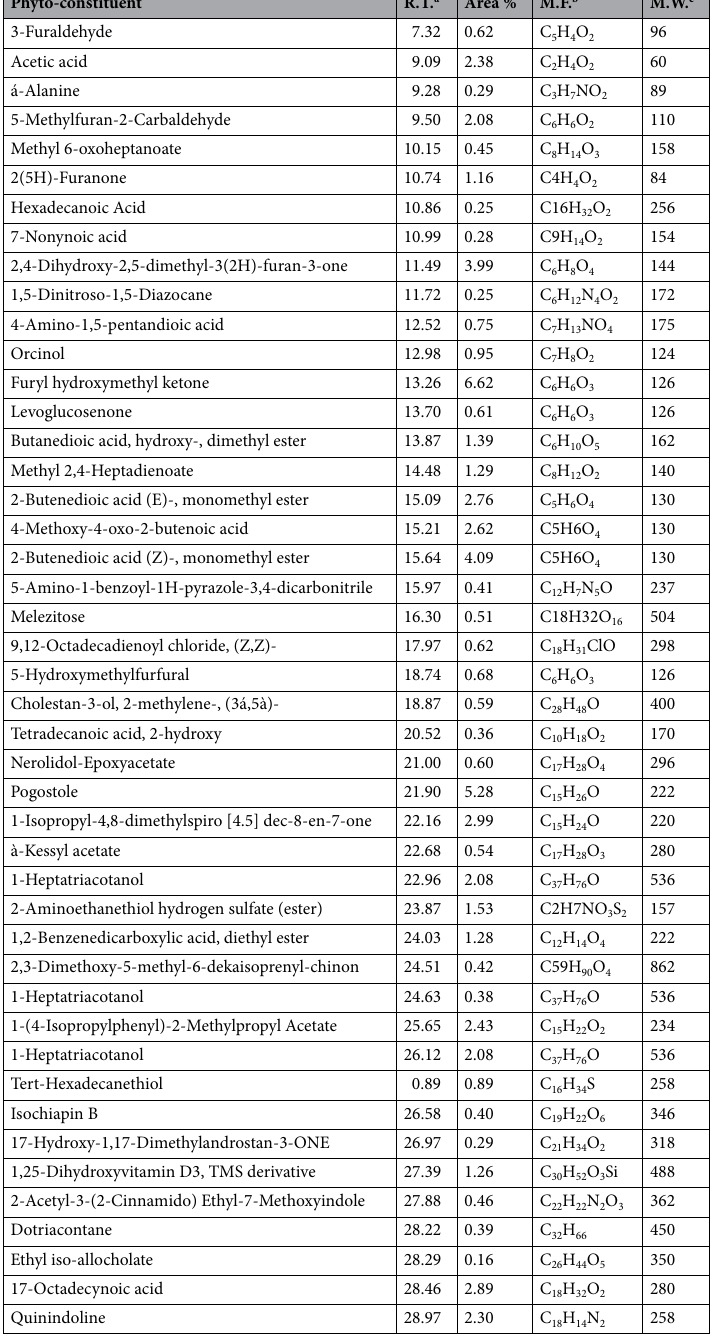
Table 2. Phyto-constituents of D. caffra fruit extract identified by GC/MS. a Retention time (R.T). b Molecular formula (M.F.). c Molecular weight